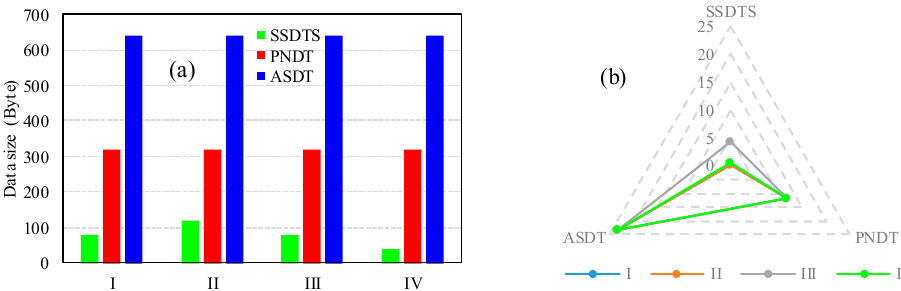
Figure 8. Sensing data size and energy consumption. ( a ) Sensing data size for different events, ( b ) Sensor energy consumption for different events.